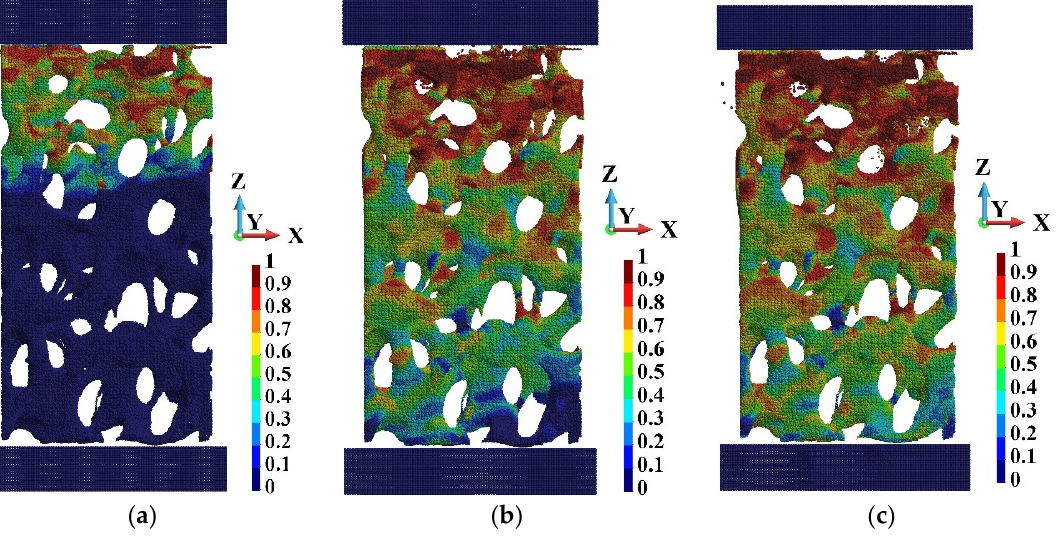
Figure 14. Damage advancement for the piston velocity 440 m/s at time instants: ( a ) 0.6 × 10 − 06 s; ( b ) 0.3 × 10 − 05 s; ( c ) 0.42 × 10 − 05 s.